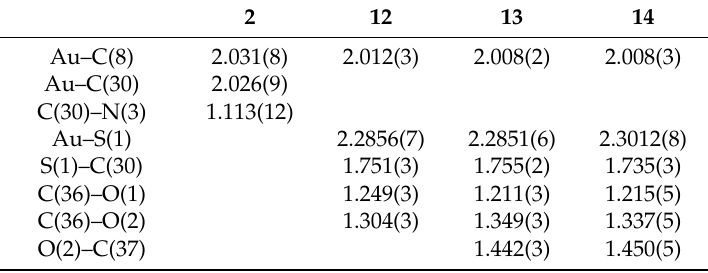
Table 2. Selected bond angles for 2 , 12 , 13 , and 14 .